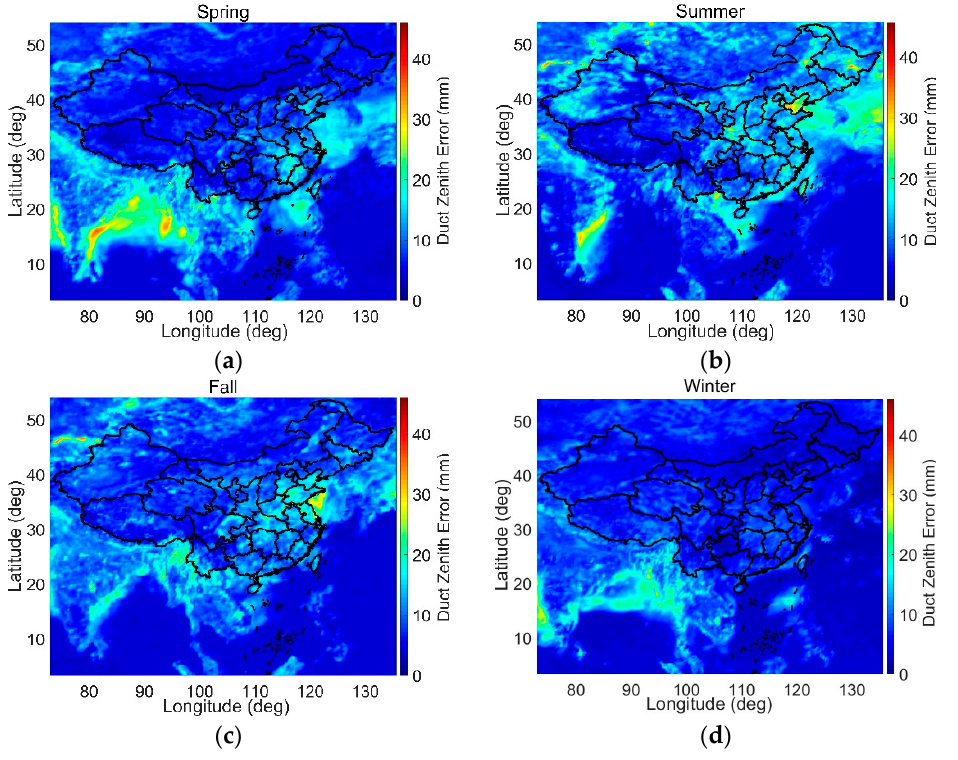
Figure 8. Maps of maximum zenith duct errors at 500 m for the four seasons. ( a – d ) show maps for the spring, summer, fall, and winter, respectively.